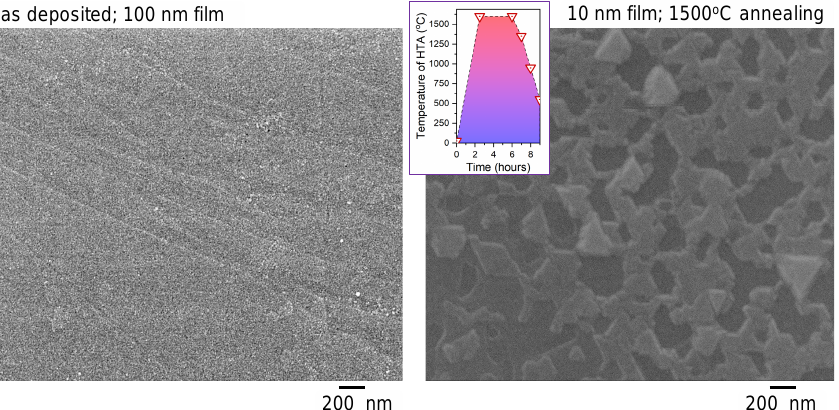
Figure A3. SEM images of the as sputtered CoCrFeNiMo 0.2 film and after high-temperature annealing at 1500 ◦ C for 2 h under N 2 flow to avoid oxidation. The substrate was Al 2 O 3 crystalline substrate with c-plane used for deposition of HEA (sapphire melts at ∼ 2100 ◦ C). For SEM imaging of the annealed sample 10 nm of Cr was coated to reduce